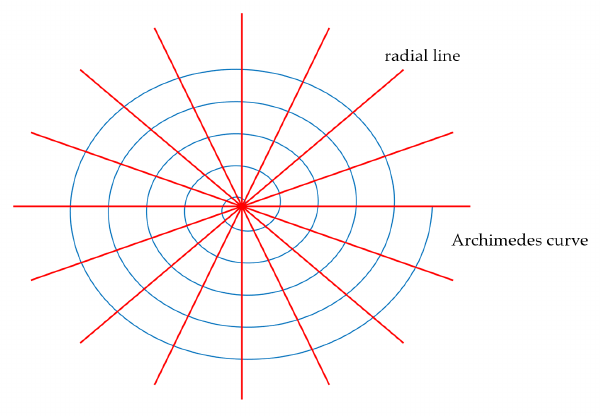
Figure 11. Plane Archimedes spiral.